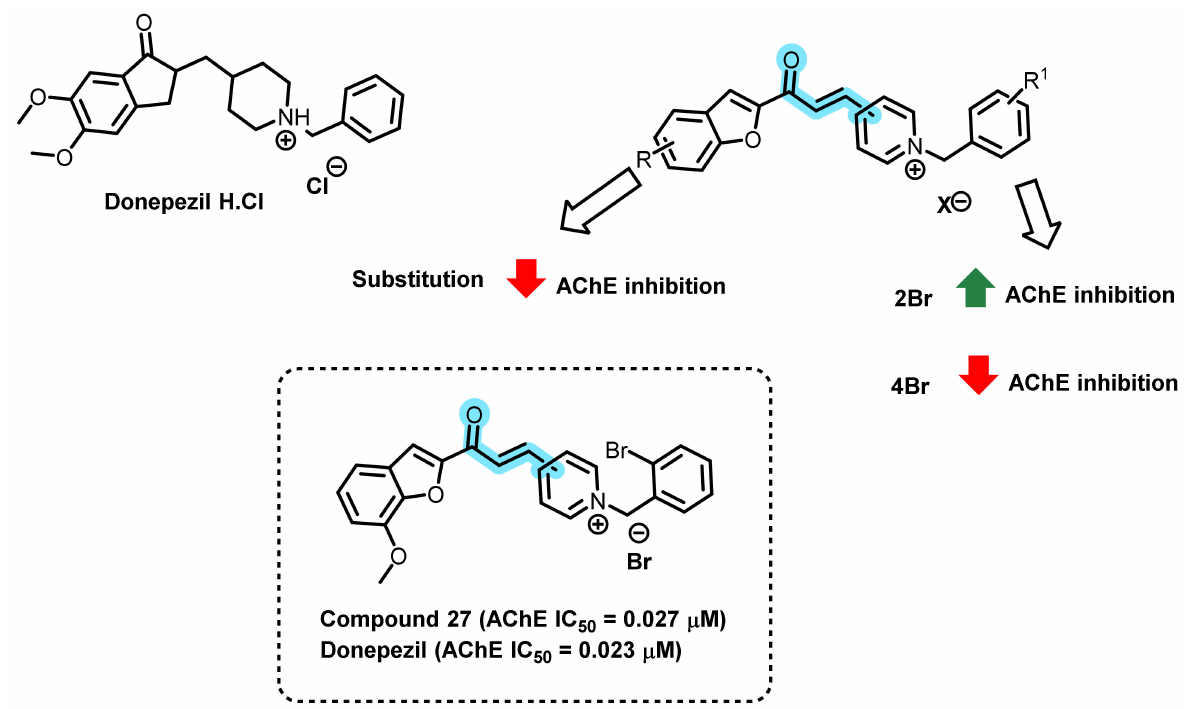
Figure 25. Benzofuran-based chalconoid-containing N-benzylpyridinium motif. Chandrika et al., synthesized a new series of donepezil–chalcone hybrids and eval- uated their ChEs inhibitory activities against Electrophorus electricus (EeAChE for AChE inhibition) and Equus ferus (EfBChE for BChE activity) (Figure 26) [61]. Numerous chal- cones such as 1,3- and 1,4-substitutes were incorporated into the donepezil and those were separated with numerous carbon chain linkers (2, 4, 6, 8, 10, and 12 carbons).